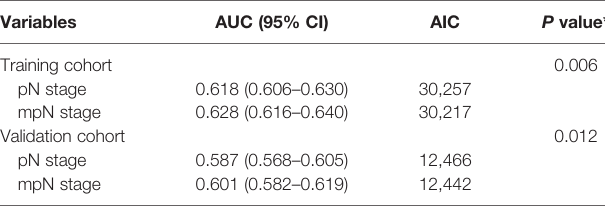
TABLE 7 | Prognostic abilities of pN and mpN stages in the training and validation cohorts. Variables